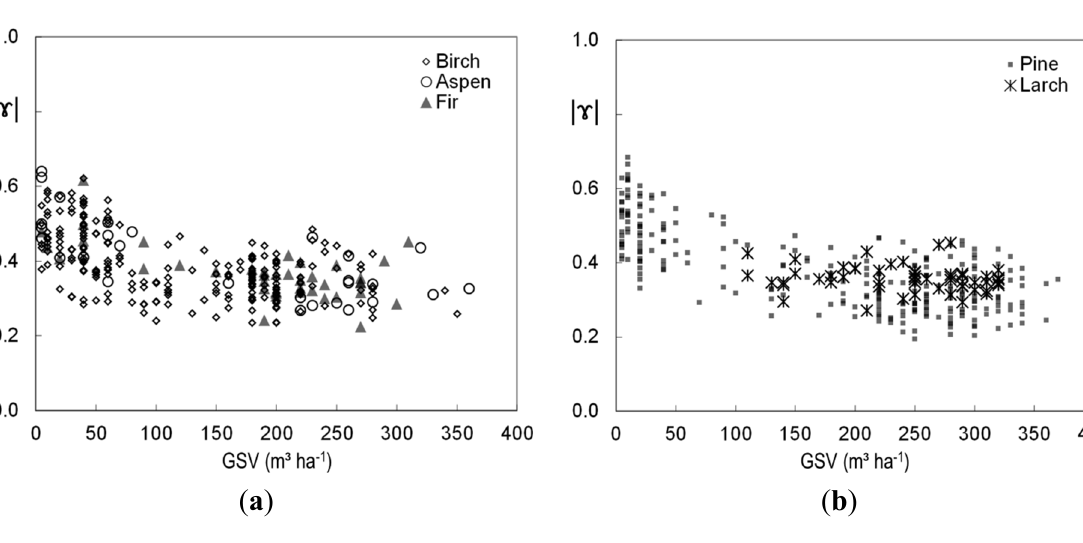
Figure 3. | γ | vs . GSV by dominant tree species for Primorsky South using two single interferograms. ( a ) and ( b ): Frozen conditions (18 January 2007–5 March 2007); ( c ) and ( d ): Non-frozen conditions (21 July 2007–5 September